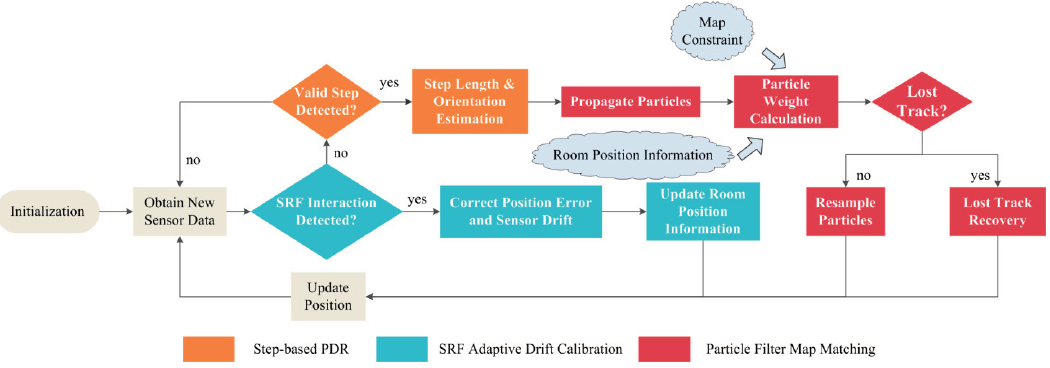
Figure 1. Overview of HILN